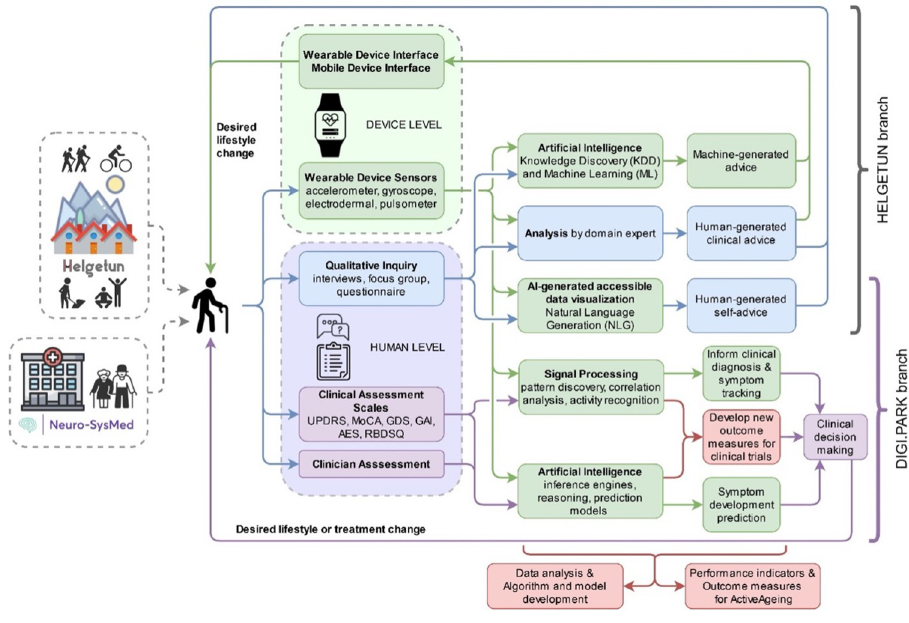
Fig 2. ActiveAgeing